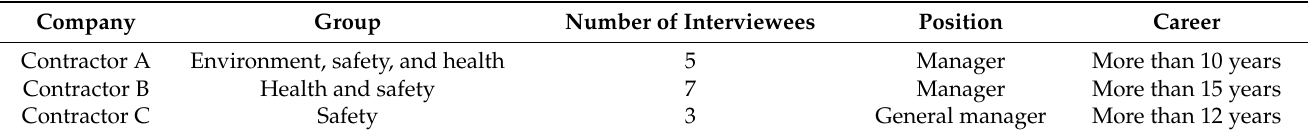
Table 4. Overview of information of expert group interview.